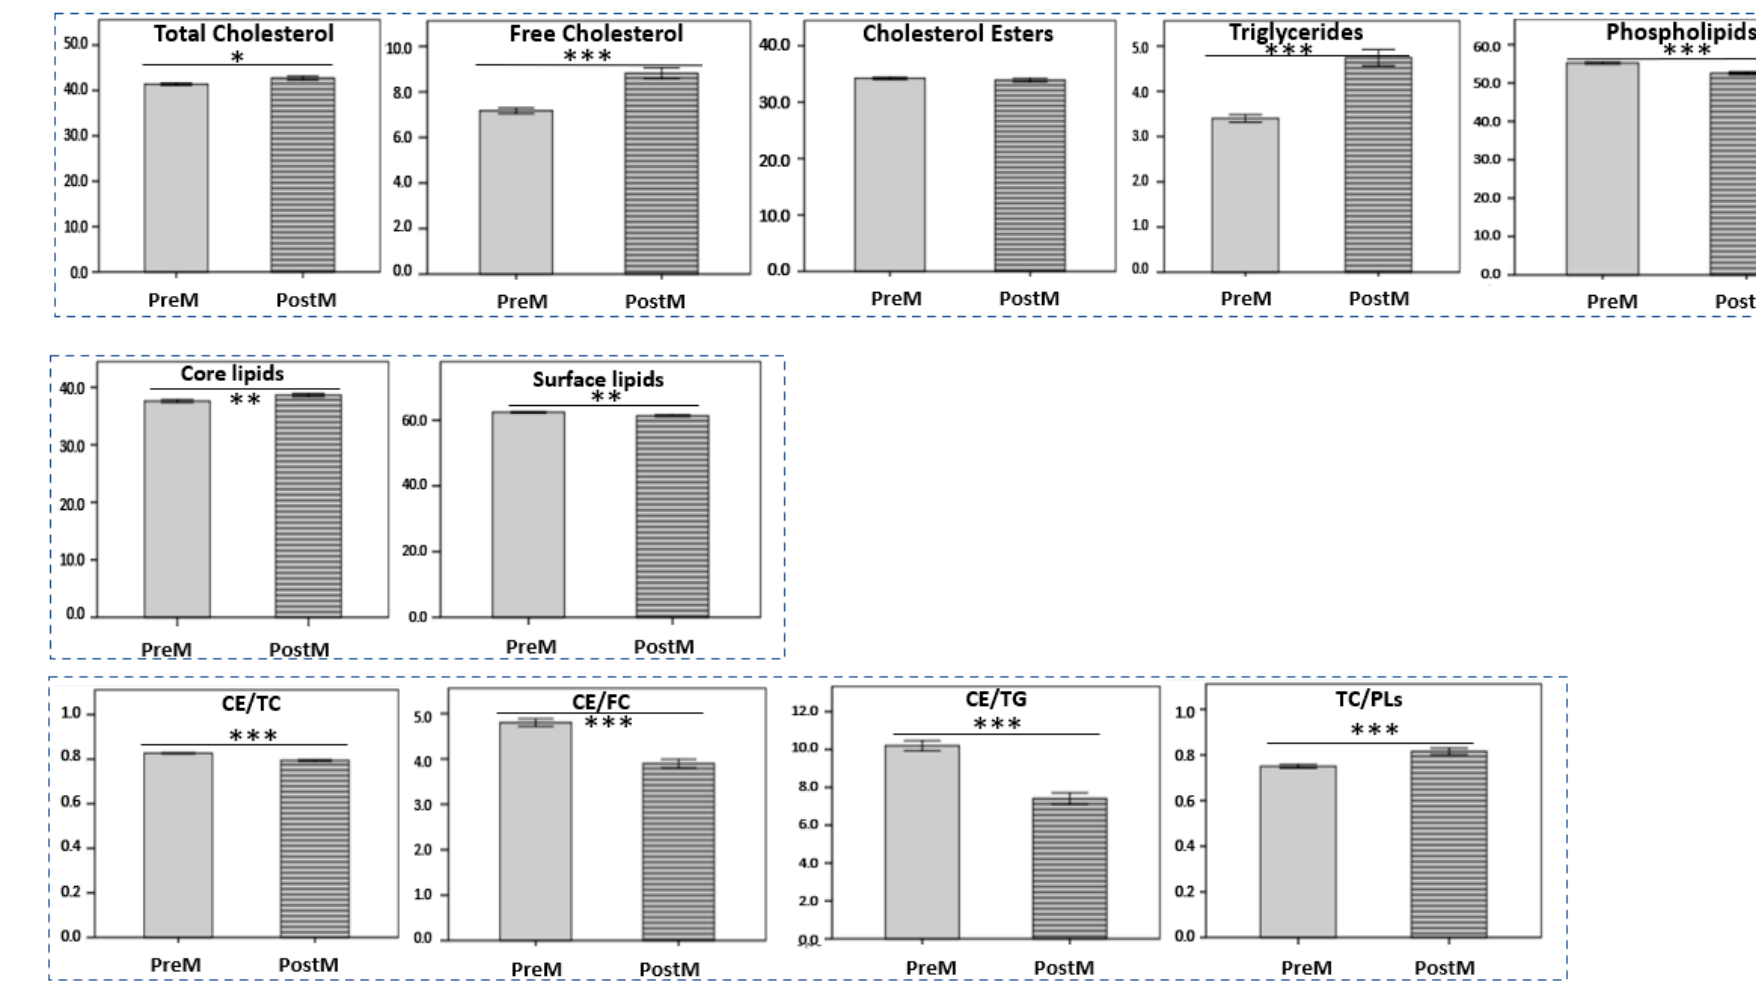
Figure 2. HDL lipid components and their ratios in the study groups (mean ± SD). PreM: premenopausal women; PostM: postmenopausal women. * p < 0.05; ** p < 0.01; *** p < 0.001: compared to the premenopausal group.